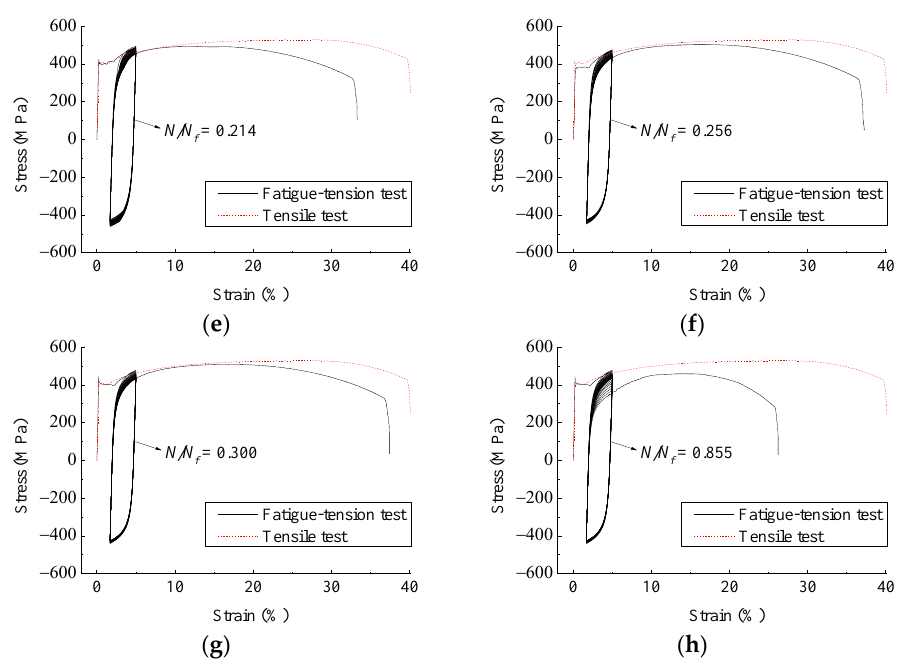
Figure 6. The stress – strain curves of fatigue-tension tests with strain amplitude of 1.70% and pre-fatigue damages of: (a) 0.043; ( b ) 0.085; ( c ) 0.128; ( d ) 0.171; ( e ) 0.214; ( f ) 0.256; ( g ) 0.300; ( h ) 0.855.